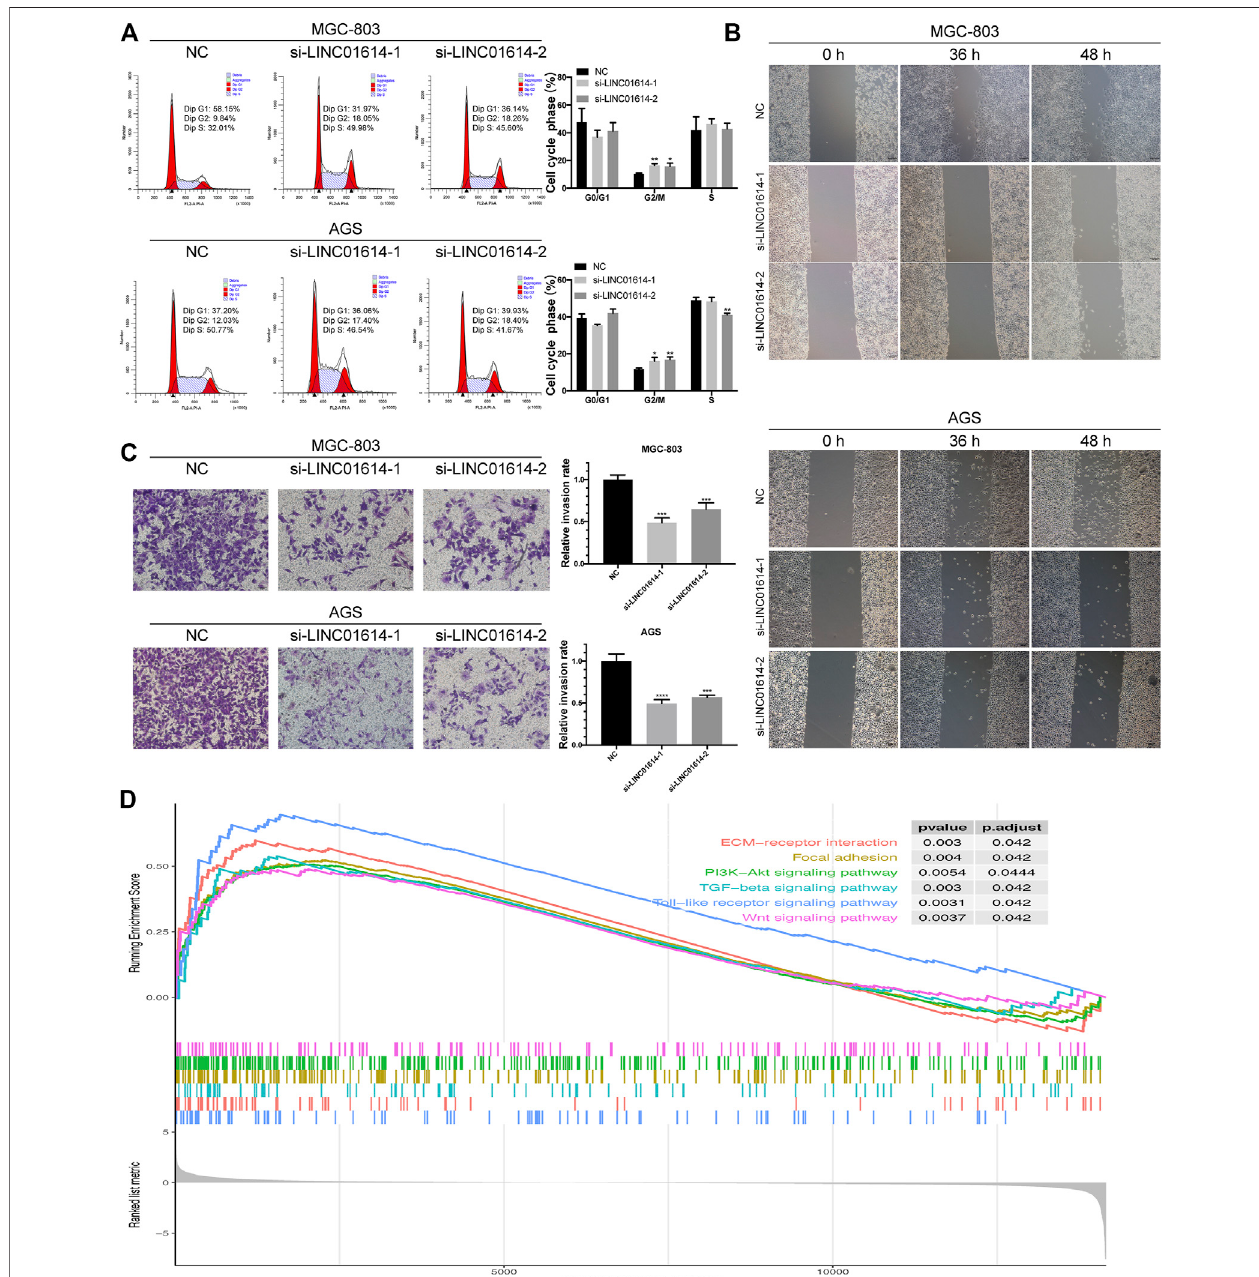
FIGURE 5 | Biological effects of LINC01614 expression exerted on cell cycle, migration, and invasion. (A) The cell cycle distribution of transfected MGC-803 and AGS cells was assessed by performing fl ow cytometry. (B) Wound healing assay was performed to determine MGC-803 and AGS cell migration after transfection. (C) The MGC-803 and AGS cell invasion after transfection was determined by performing transwell assay. (D) Enrichment plot generated from gene set enrichment analysis data.